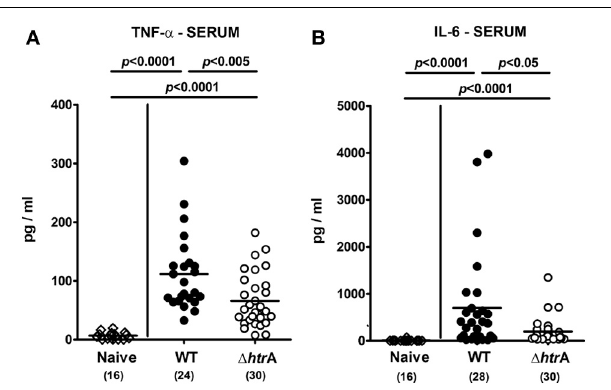
FIGURE 5 | Systemic pro-inflammatory cytokine responses following C. jejuni infection of gnotobiotic IL-10 − / − mice. (A) TNF- α and (B) IL-6 levels were determined in serum samples taken at day 6 p.i. Data shown were pooled from five independent